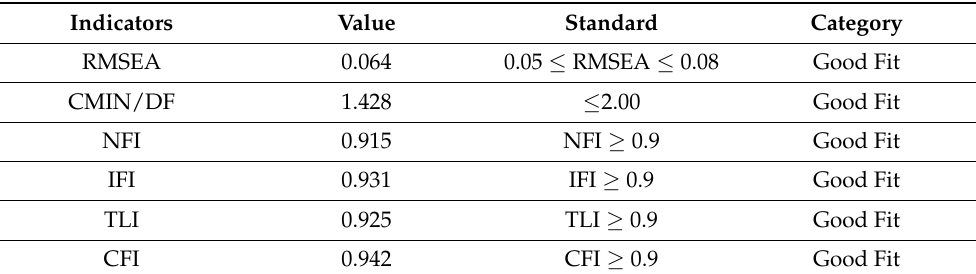
Table 4. Goodness of